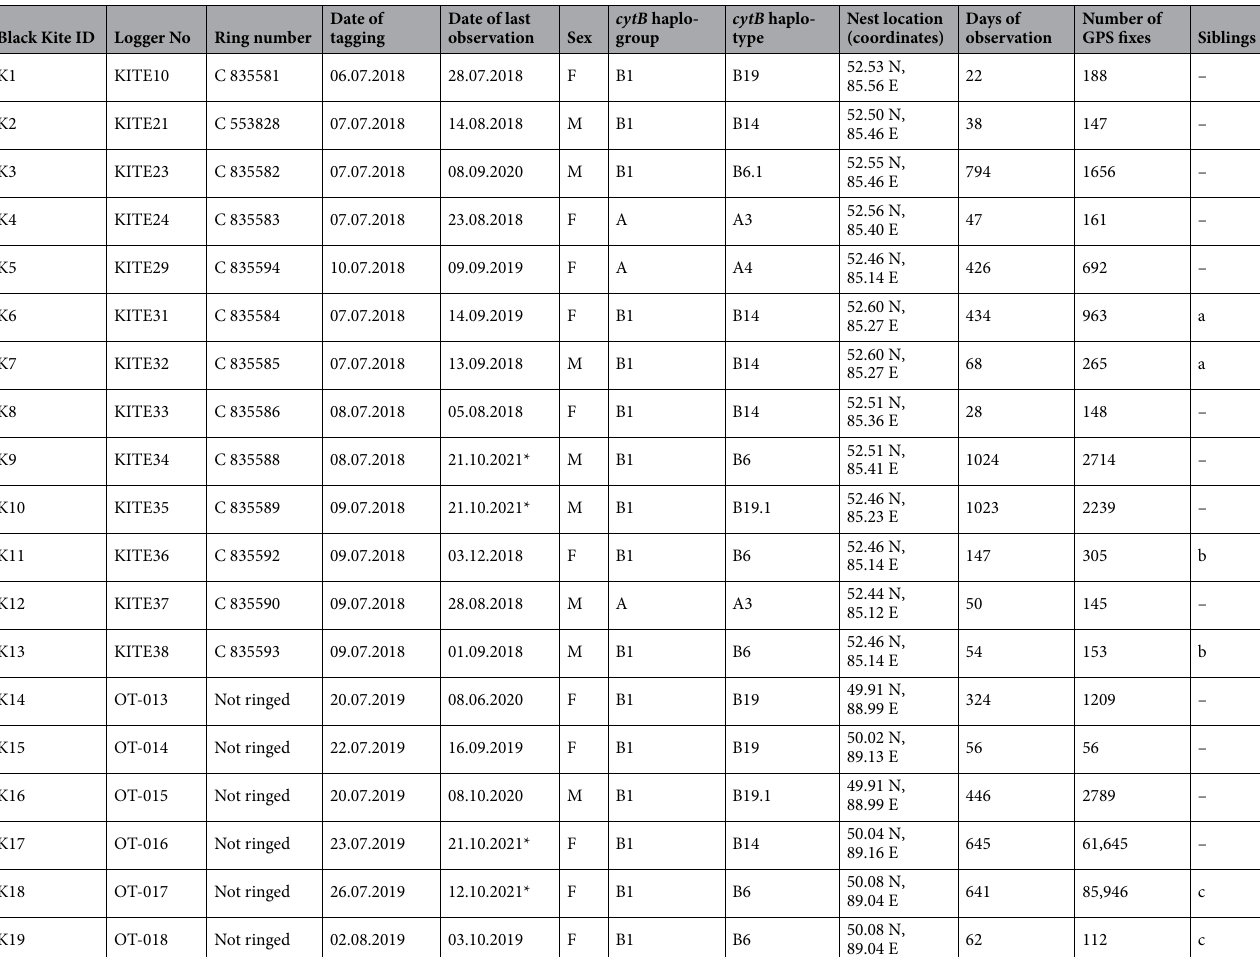
Table 1. Black Kites from western Siberia, Russia tracked with telemetry devices. All birds were tagged as pulli . F, female; M, male; * birds were tracked also after 30 June 2021 (further data not included in this paper); aa, bb, cc, pairs of